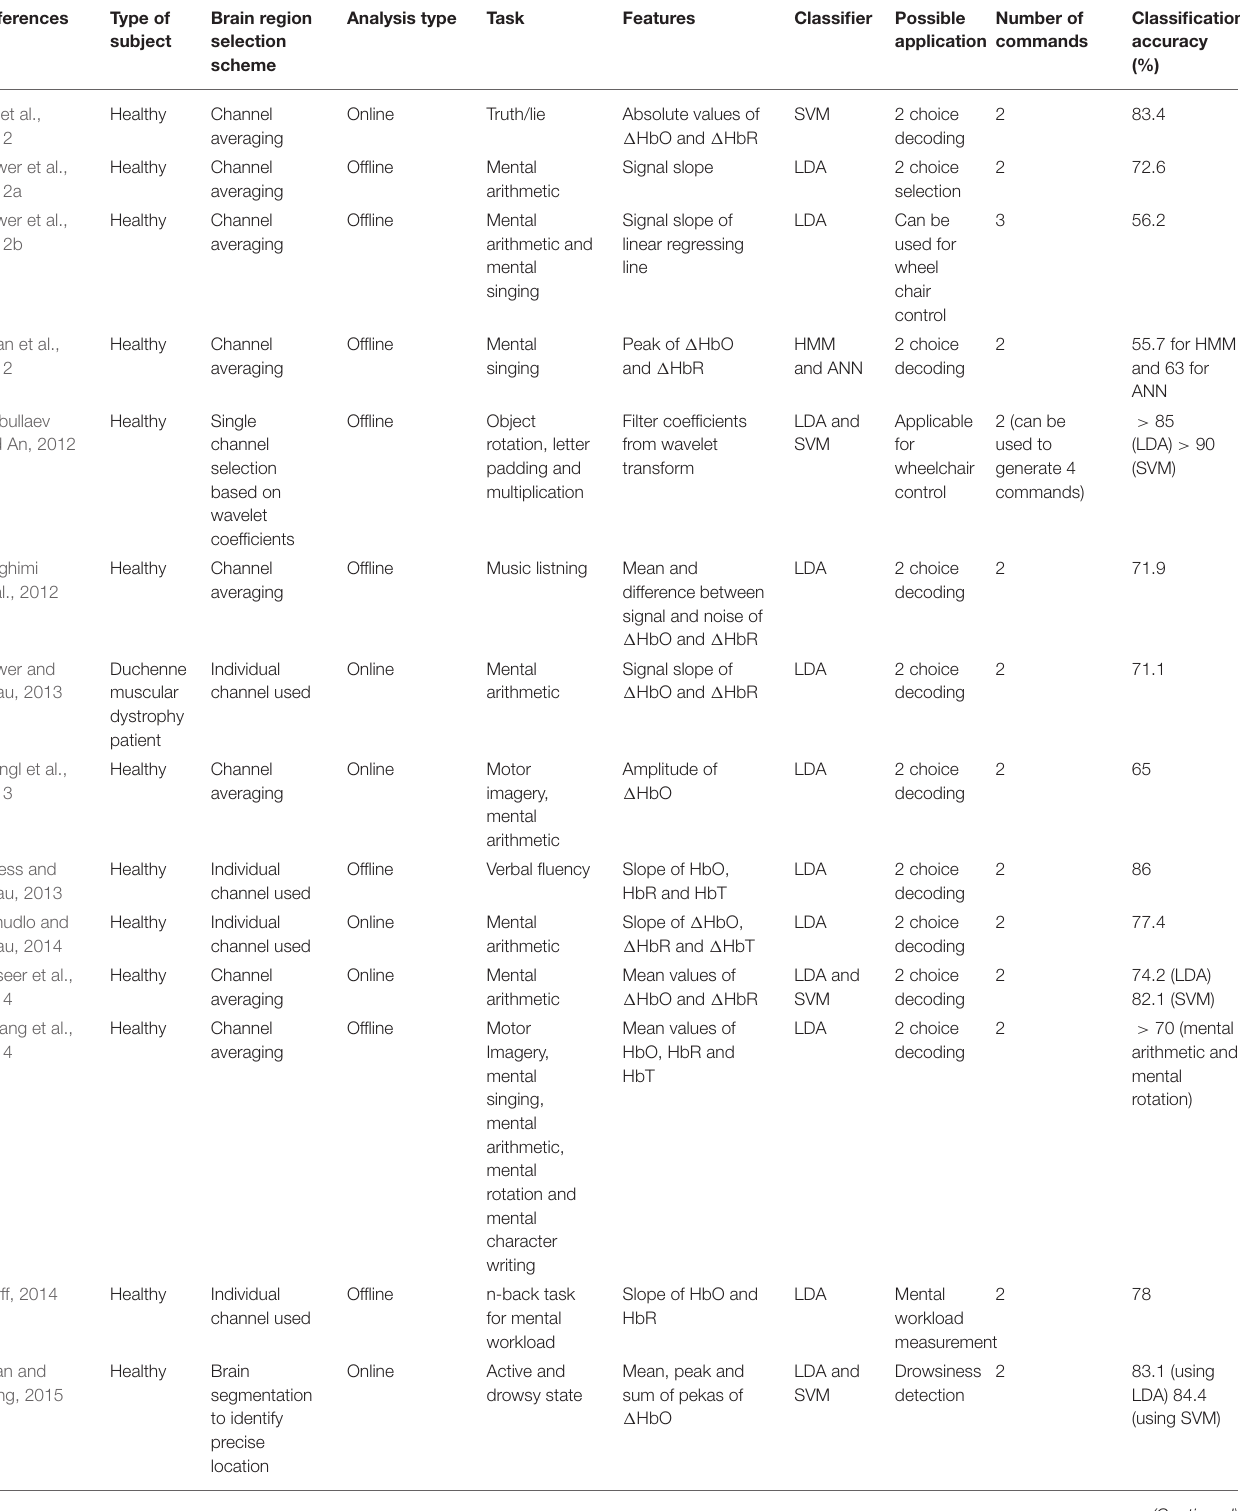
TABLE 3 | fNIRS-BCI studies (2012–2017) that decoded brain activities from the prefrontal